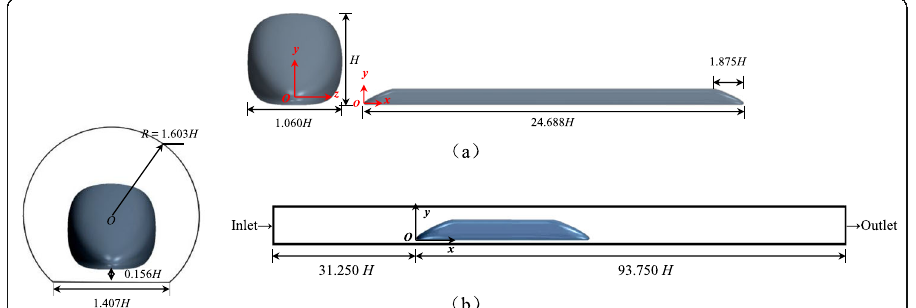
of the tube train